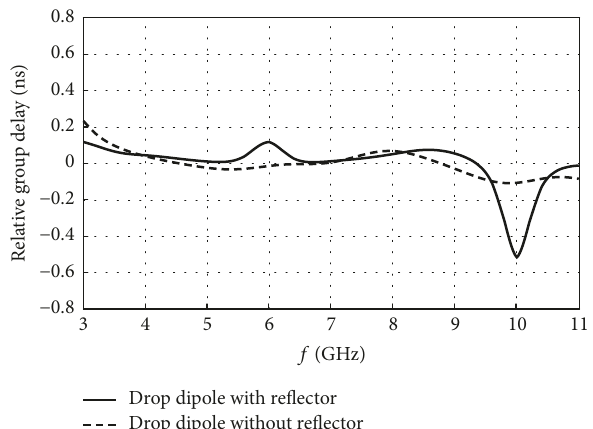
Figure 12: Frequency behaviour of the group delay featured by the antenna with and without metal reflector. The presence of a peak appearing at the end of the UWB band does not jeopardize the good radiation performance of the proposed antenna.